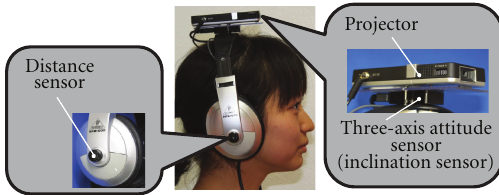
Figure 3: Concert Viewing